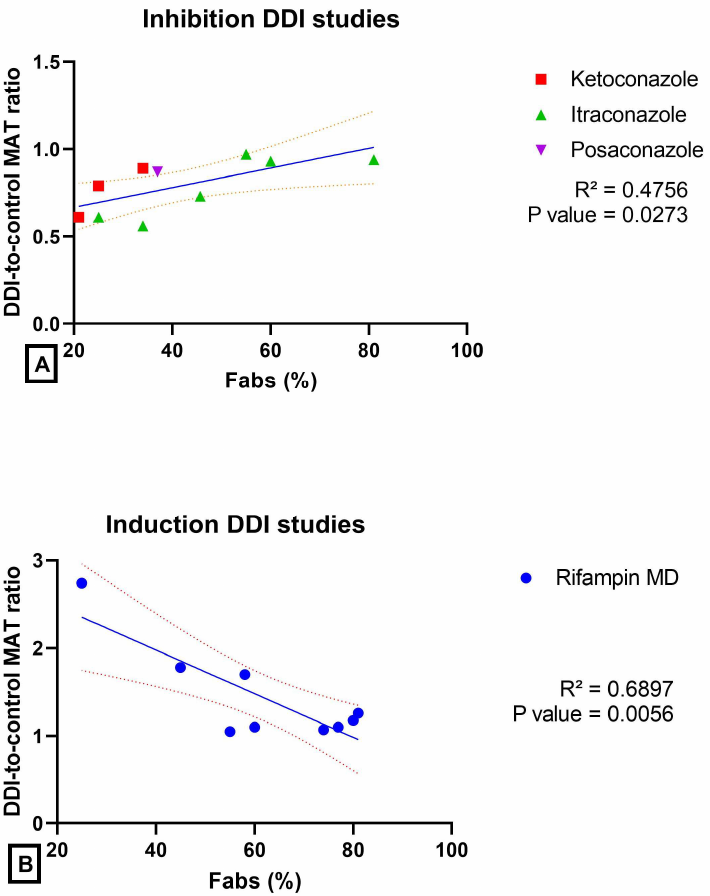
Figure 7. The magnitude of the effect of a DDI on the absorption rate of a drug (estimated by MAT ratio) as a function of the absolute bioavailability (Fabs) in a series of oral targeted anticancer drugs. ( A ): inhibition DDI studies (KETO-ITRA-POSA). ( B ): induction DDI studies (RIF). The coefficient of determination R 2 and the P value on the linear correlation is indicated for each relationship, and the 95% confidence interval is represented on each plot.